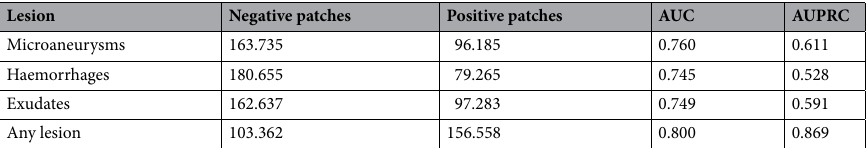
Table 3. Resulting AUC and AUPRC scores when using the attention weight of a patch as a binary predictor of lesion presence. We report scores against different lesion types individually, as well as all lesions combined. Results are produced using images of the IDRiD dataset for which pixel-level lesion annotations are available.